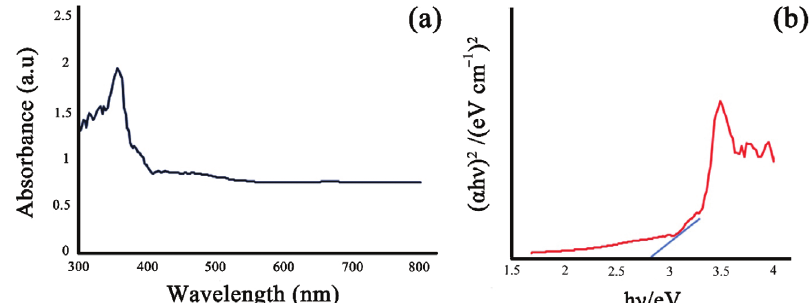
Figure 17: DRS and plot of ( α h ν ) 2 versus ( h ν ) of sample no. 1.